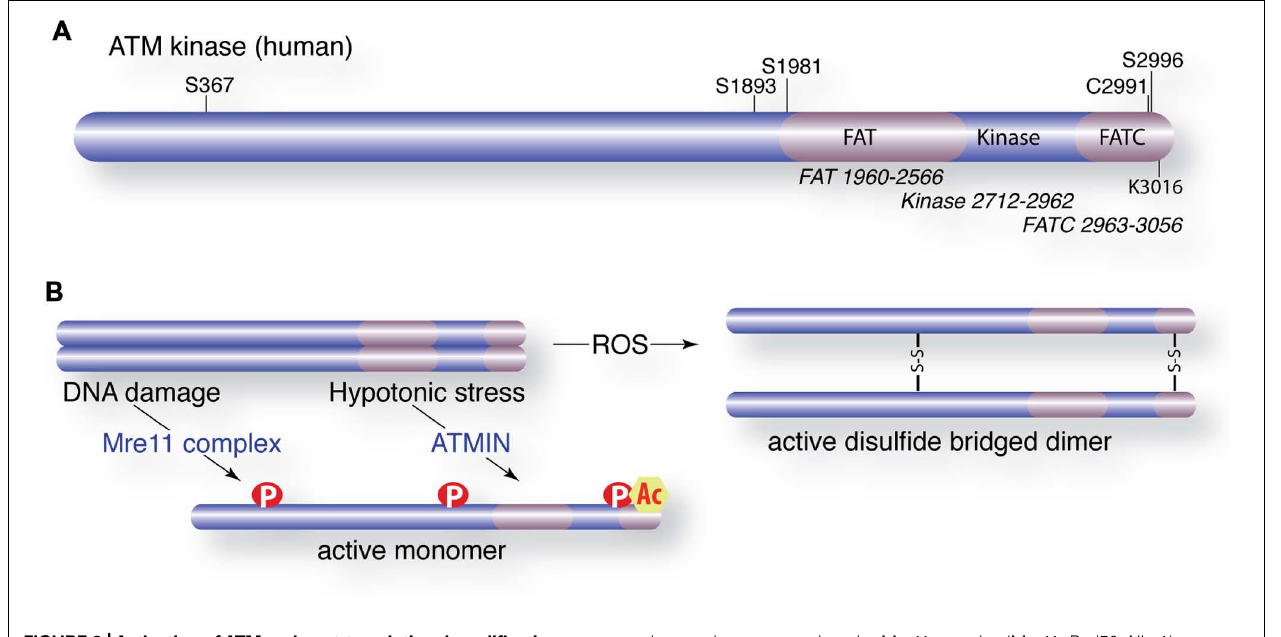
hypotonic stress requires the Mre11 complex (Mre11, Rad50, Nbs1) or ATMIN, respectively. Activated ATM is monomeric, phosphorylated and acetylated. Alternatively, ATM is activated directly by ROS that oxidizes cysteine residues to promote disulfide bridge-mediated